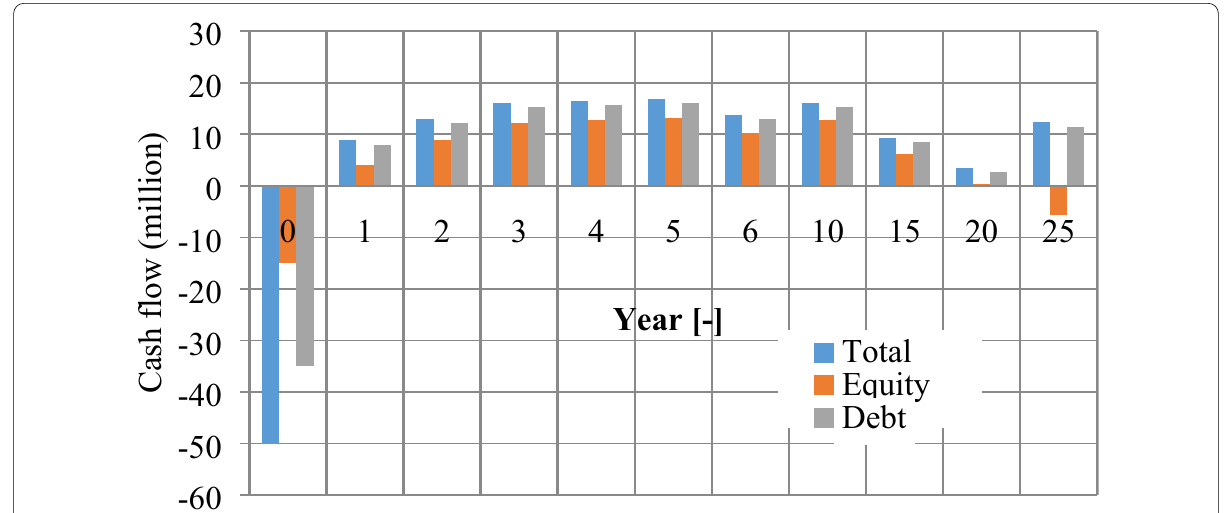
Fig. 5 Annual cash flows to investors